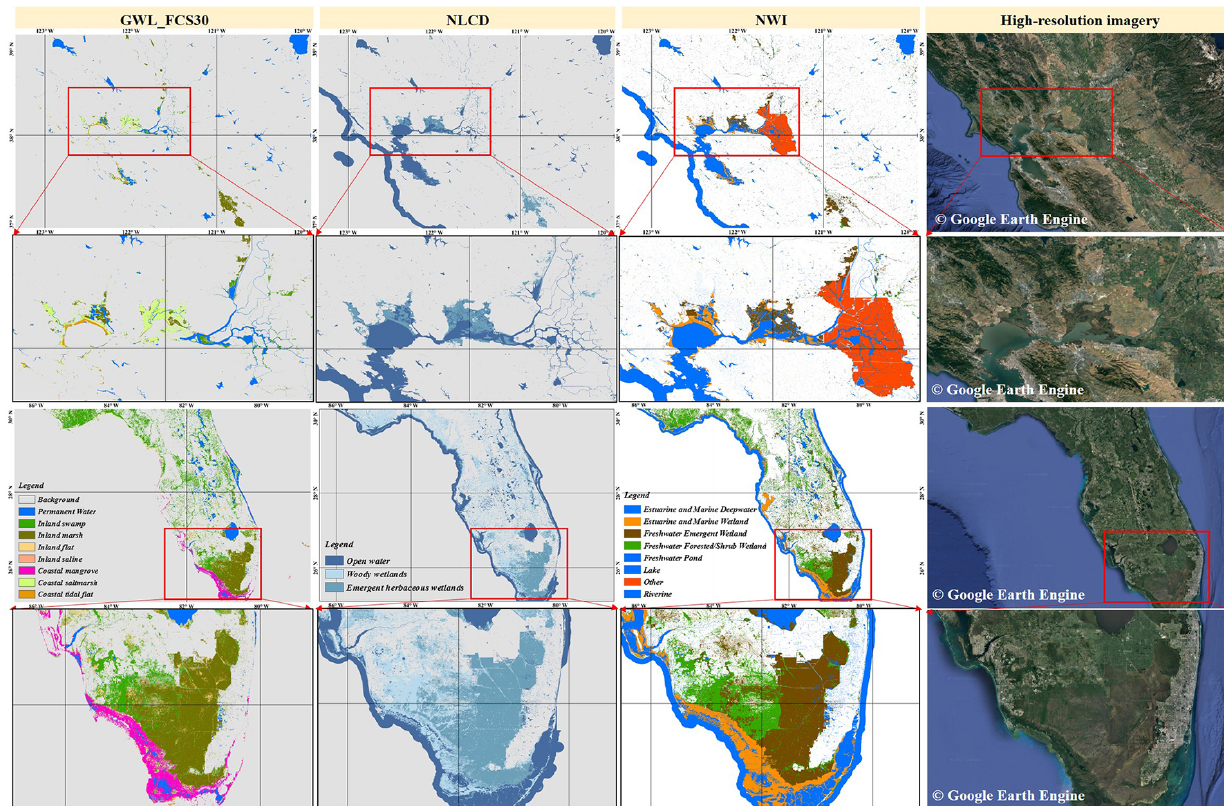
Figure 16. The comparisons between GWL_FCS30 in 2020, National Land Cover Database (NLCD) wetland layer (Homer et al., 2020) and National Wetlands Inventory (NWI, https://www.fws.gov/program/national-wetlands-inventory, last access: 12 November 2022) in San Francisco and Florida. The high-resolution imagery comes from the © Google Earth Engine platform (https://earthengine.google.com; last access: 12 November 2022). Table 7. The accuracy metrics between CLC and GWL_FCS30 after merging the wetland categories. CLC NWT WC WB CL ET SO Peat bogs and inland marshes SMH TFT O.A. Kappa U.A. 92.94 94.81 68.63 35.86 62.90 P.A. 82.80 57.76 83.93 91.23 75.00 NWT PW SWP MSH FFT SMH TFT O.A. Kappa U.A. 91.22 88.02 80.98 86.21 94.35 GWL_FCS30 P.A. 88.54 97.69 80.82 91.91